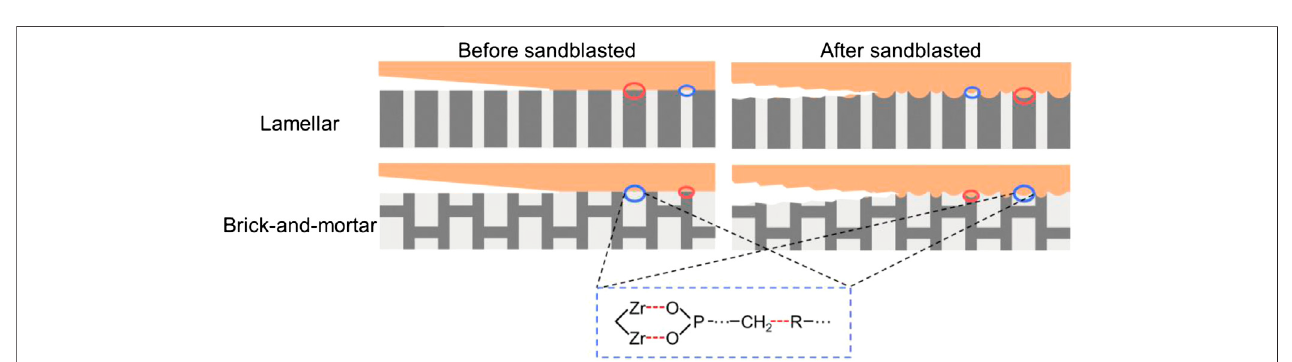
FIGURE 8 | Possible bonding mechanism diagrams at the bonding interface of the Lamellar and Brick-and-mortar group.